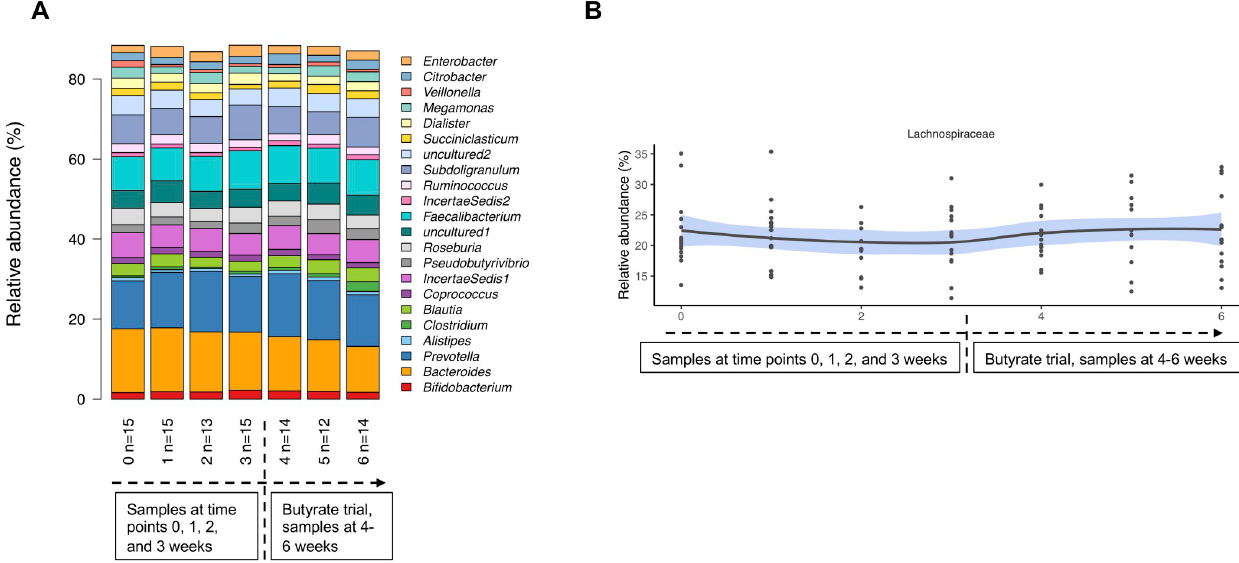
Fig 5. Effects of butyrate on microbiome in subjects with congenital chloride diarrhea (CLD). Shown are (A) clustered stacked column graphs demonstrating microbiota differences at the genus level at the study entry (time point 0) and further during the standard salt substitution (time points 1, 2, and 3 weeks), and during the butyrate trial (time points 4, 5, and 6 weeks), and (B) microbiota changes for Lachnospiraceae at the family level at the different time points ( P < 0.01; CovariateTest for the changes after starting the administration of butyrate). The line defines mean and shaded area 95% confidence